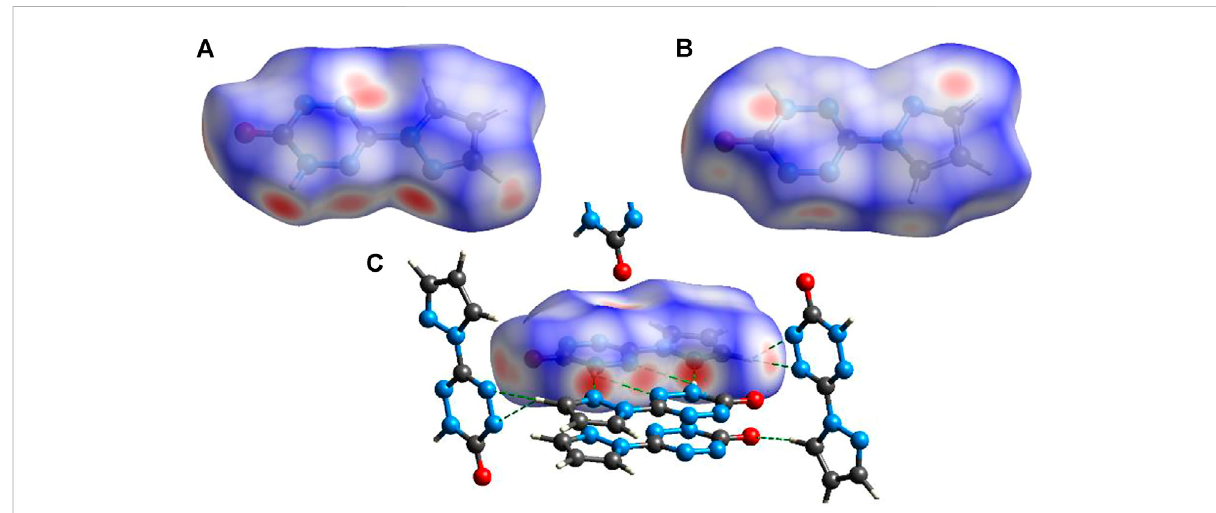
parameters in Table 1 at different heating rates are listed in Supplementary Table S5. As can be seen, when the hydrazine group is replaced by carbonyl, the values of Δ G ≠ , Δ H ≠ , and Δ S ≠ are all improved, demonstrating that the thermal safety of compound 6 is better than that of 2 . As for the energetic salts of 6 , the order of thermal safety is 7 > 9 > 8 , which is consistent with their thermal behaviors.